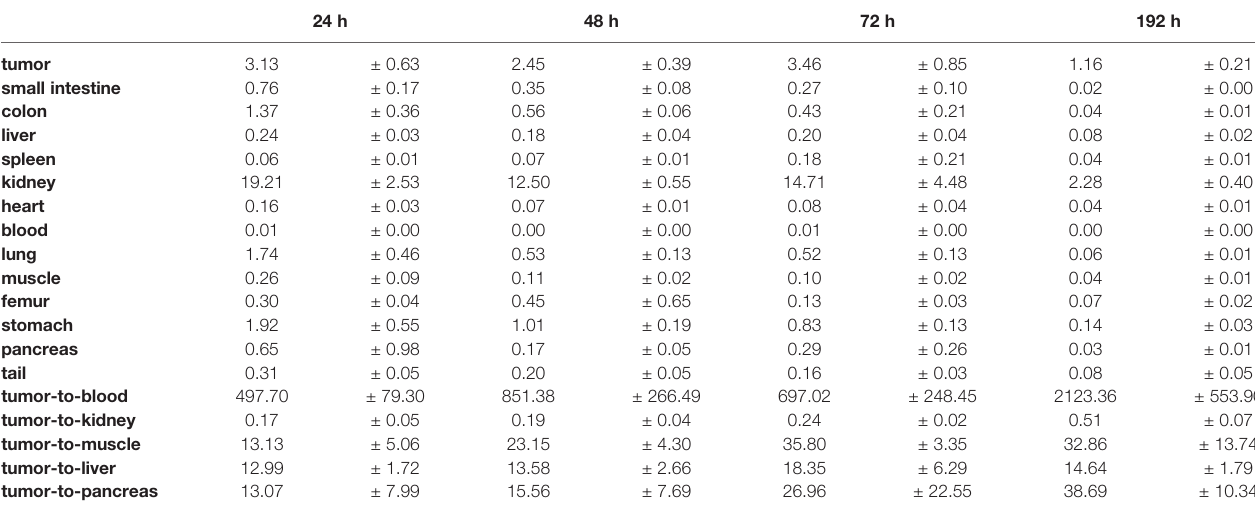
TABLE 2 | Biodistribution (%IA/g, mean ± SD) and tumor-to-organ ratios of 177 Lu-DOTA-integrin a v b 6 knottin in nude mice bearing Capan-2 xenografts. 24 h